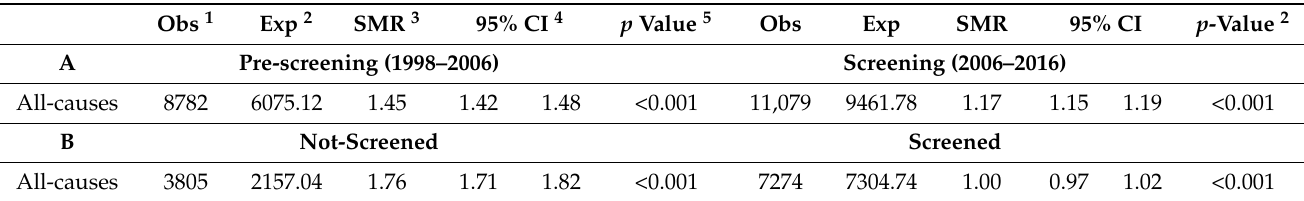
Table 2. Standardized all-cause mortality ratios during pre-screening and screening period (A) and of screened and not-screened persons